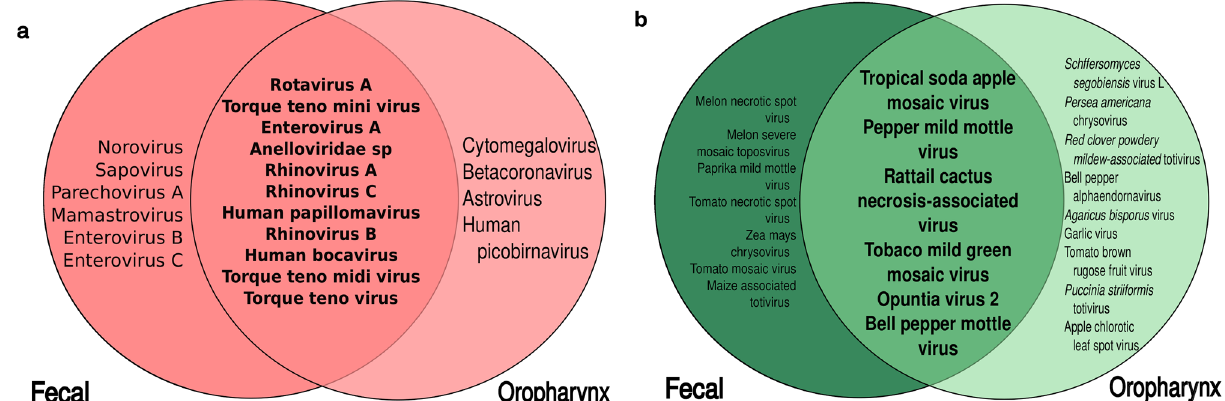
Figure 6. Venn diagram showing shared (in bold) and unique species in each tract that are known to infect humans ( a ) or plant and/or fungi ( b ). Species names are ordered according to their abundance, from highest to lowest in each area of the